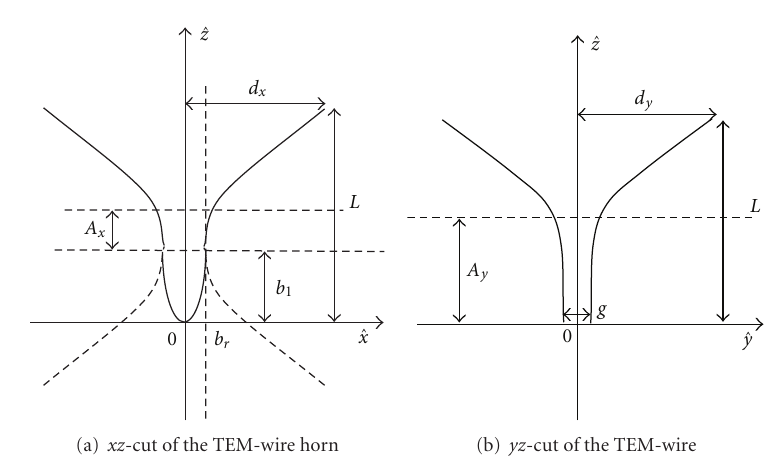
Figure 2: Structure of the TEM-wire